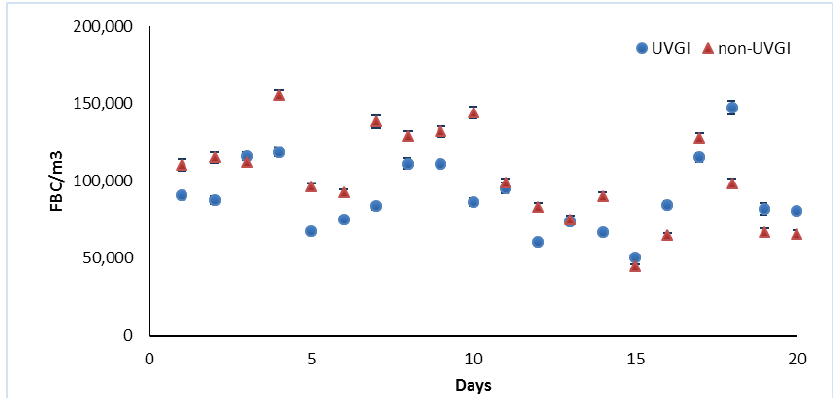
Figure 3. Comparison of fine size A FBCs between UVGI and non-UVGI control classrooms, before adjustment. non-UVGI: non-UVGI classrooms.